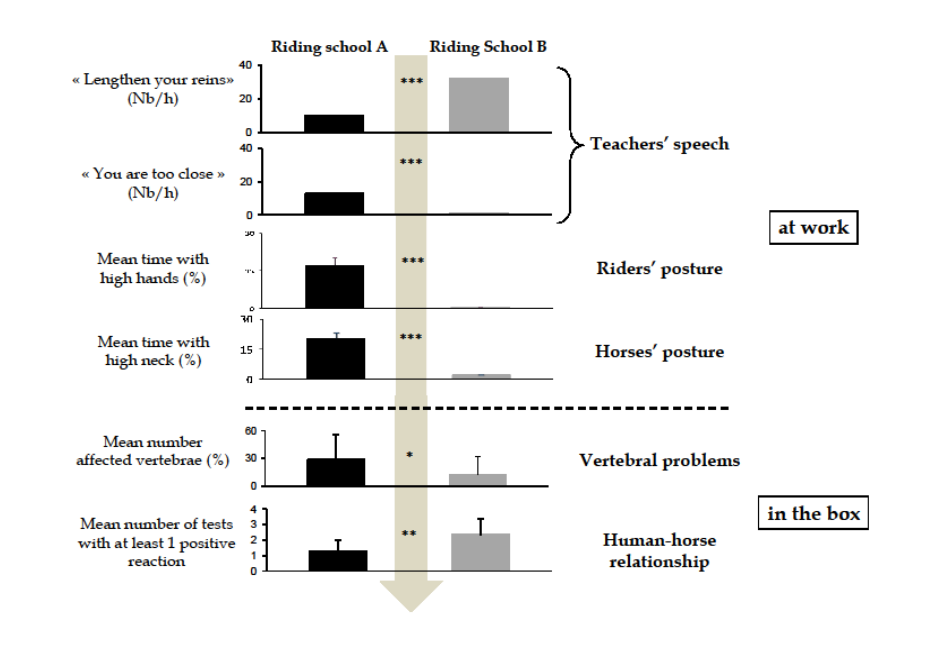
Figure 2. Impact of teaching practices on the riders’ and horses’ postures during lessons, and consequences on horses’ back disorders and human-horse relationship. When the teacher was more attentive to the riders’ positions, horses were less observed with high neck, had less back disorders and a better human-horse relationship. In the contrary, when the teacher paid more attention to the control of the horse, riders were more observed with high hands, horses with high neck and they presented more vertebral disorders and were more aggressive towards